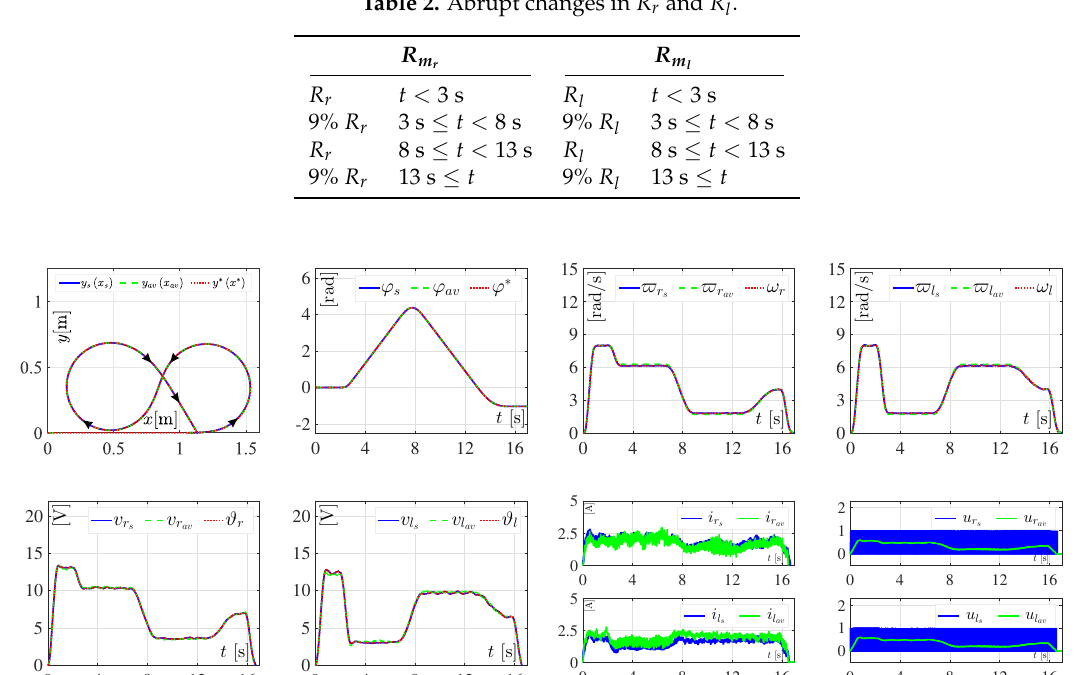
Figure 5. Experimental results in closed-loop when abrupt changes in R r and R l appear. The results associated with the hierarchical switched controller are denoted as y s ( x s ) , ϕ s , (cid:118) r u r , and u l . The results related to the hierarchical average controller are labeled as y av ( x av ) , ϕ av , (cid:118) r s s